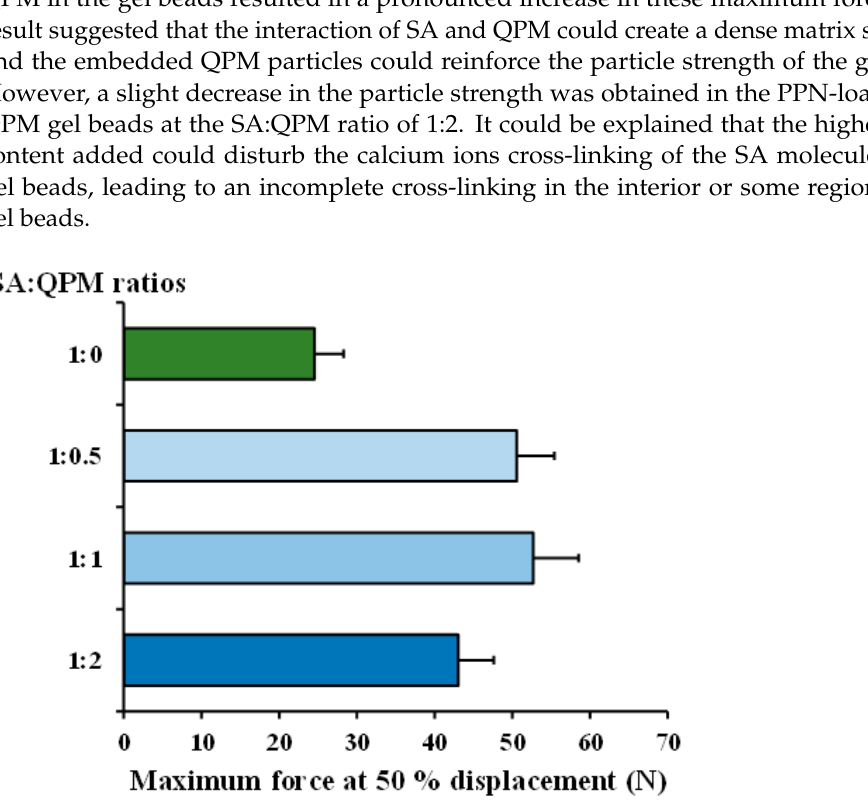
Figure 6. Mechanical property of PPN-loaded CA-QPM gel beads at different SA:QPM ratios. Each value is the mean ± S.D., n = 10.